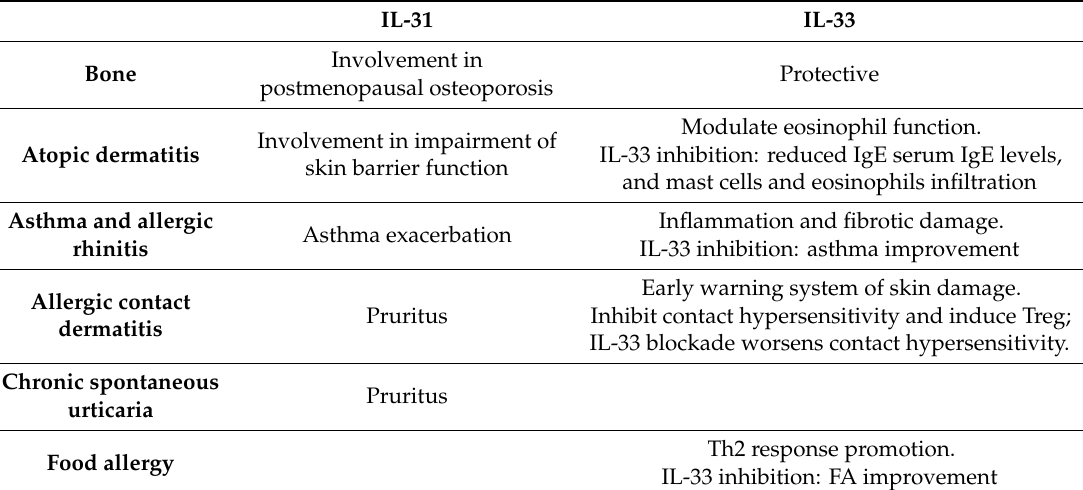
Table 1. Bone, allergic diseases, and the IL-33 / IL-31